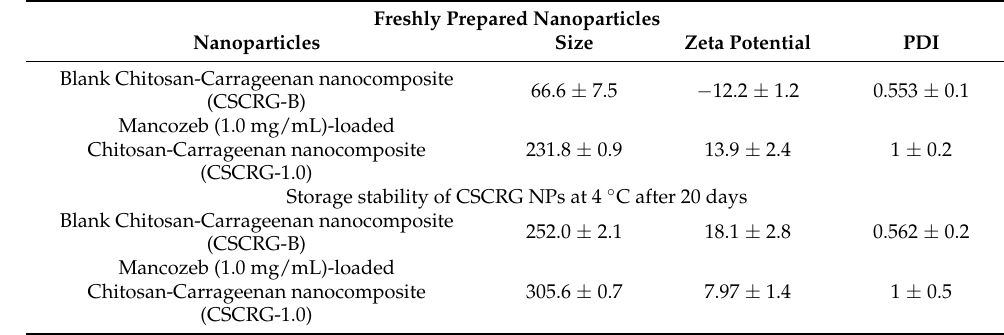
Table 2. Size, zeta potential and PDIs of freshly prepared and stored blank and mancozeb-loaded CSCRG NPs.